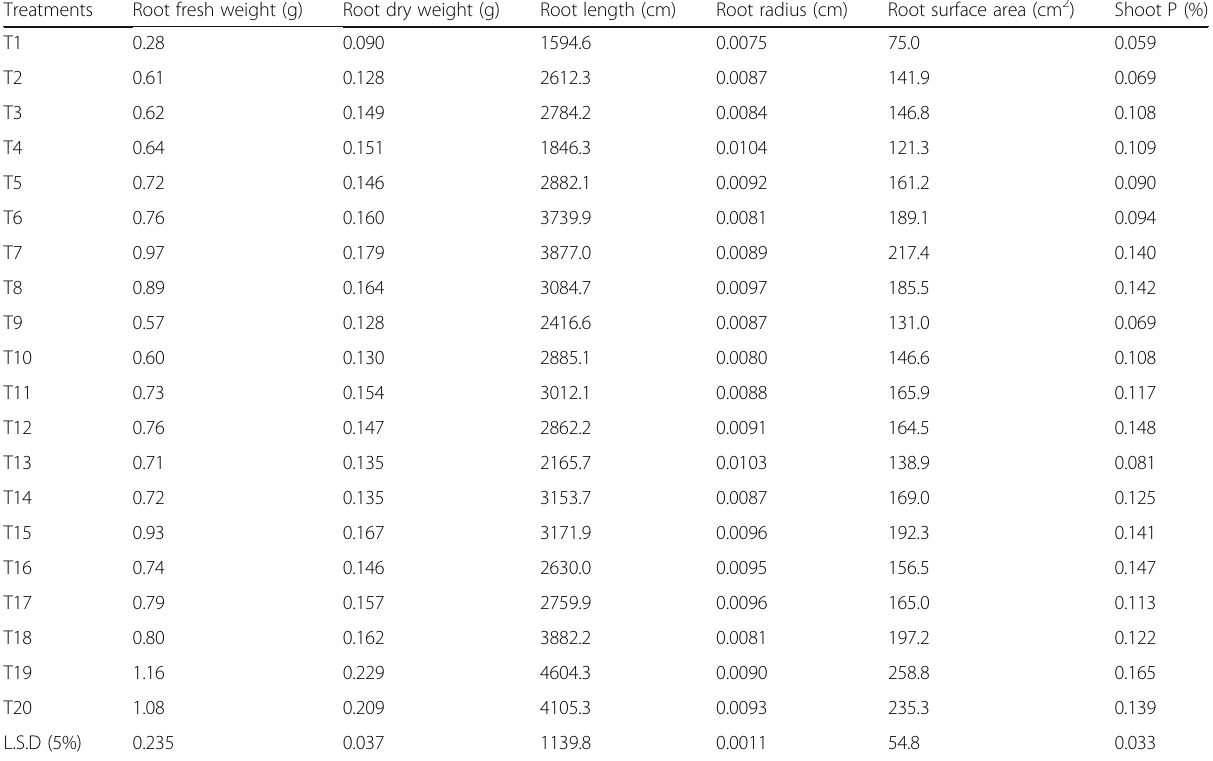
Table 4 Interaction effect (bacterial strain × phosphorus fertilizer %) on root growth parameters